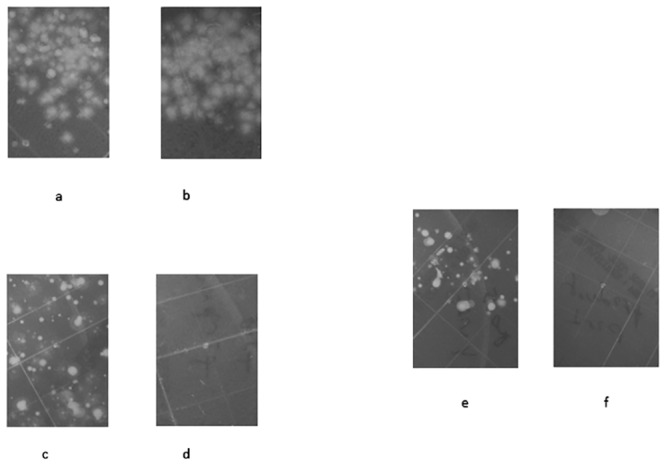
RODAC plate samplings of swine skin contaminated with B. anthracis spores.Photos of RODAC plate samplings of swine skin contaminated with B. anthracis spores. a) Pre-soapy water exposure. b) Pre-chlorine dioxide decontaminant exposure. c) Post- 30 second scrub and 5 minute soapy water total contact time. d) Post- 30 second scrub and 5 minute total contact time. e) Soapy water scrub brush after scrubbing skin for 30 seconds with soapy water. f) Chlorine dioxide decontaminant scrub brush after scrubbing skin for 30 seconds with chlorine dioxide decontaminant.